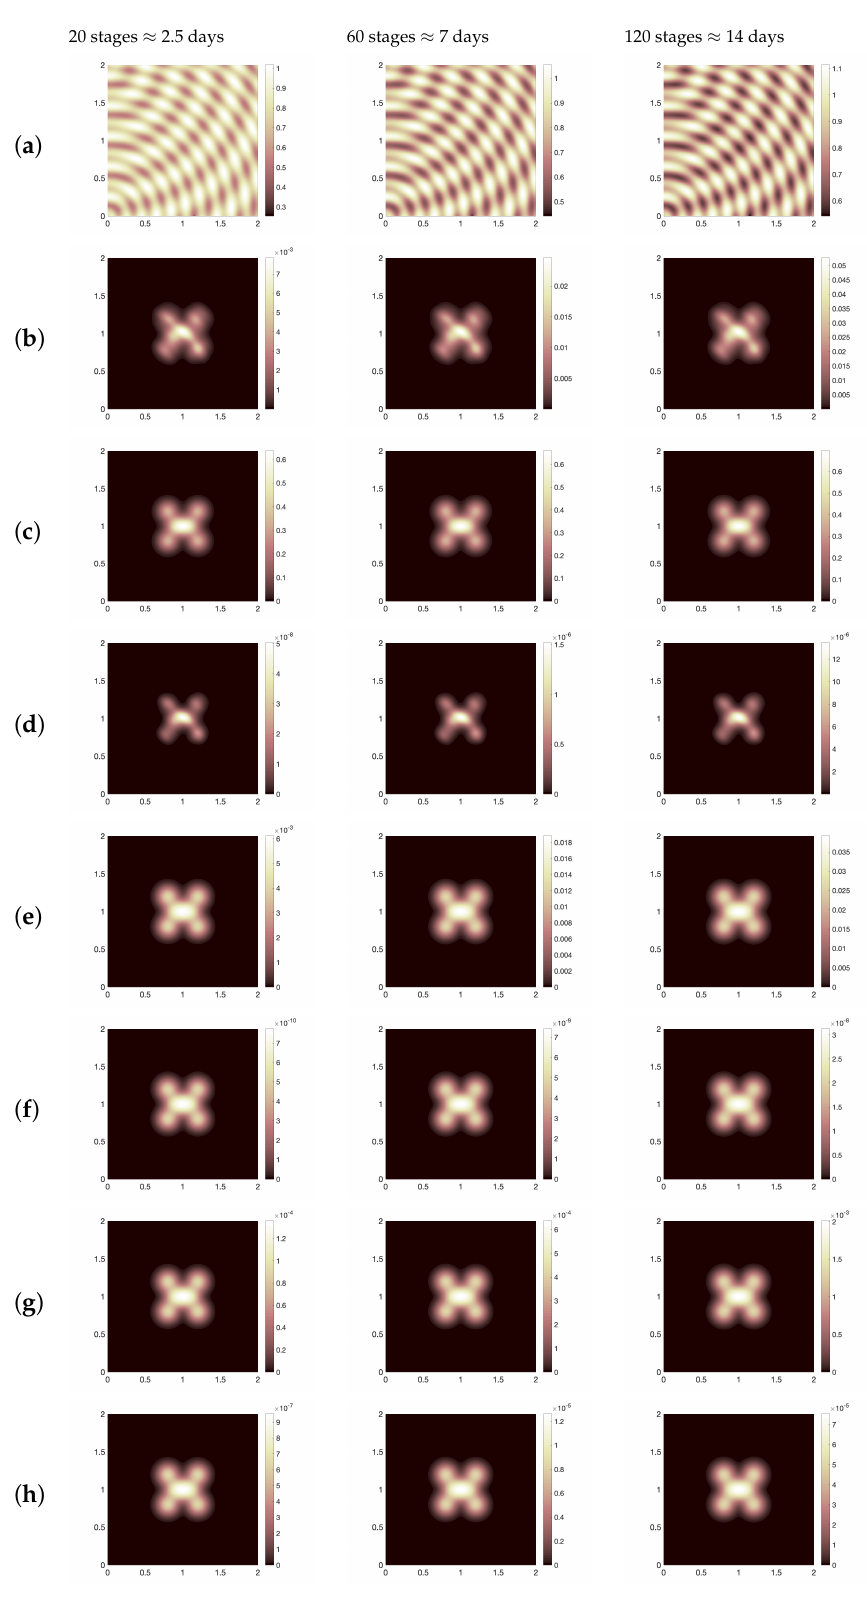
Figure 2. Spatial distribution for all dynamics in system (8) at three time stages (20, 60 and 120) using the baseline parameter values from Table 1, presenting: ( a ) healthy cells density, ( b ) infected cells density, ( c ) SARS-CoV-2 particles density, ( d ) chemokines density, ( e ) the effector T cells density, ( f ) the regulatory T cells density, ( g ) B-lymphocytes cells density and ( h ) antibodies